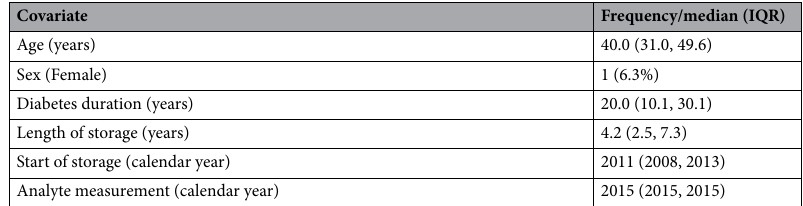
Table 1. Patient characteristics at the time of sample collection, and storage time of the 16 discovery samples. We report median and interquartile range (IQR) for continuous variables, and N (frequency) for categorical